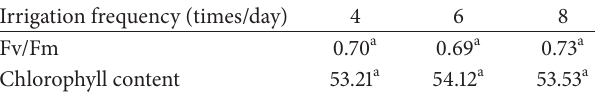
Table 2: Effect of irrigation frequencies on chlorophyll fluorescence efficiency (Fv/Fm) and chlorophyll content.